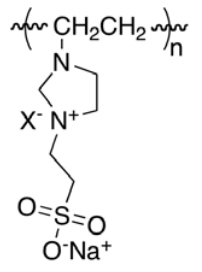
X - = OH - , SH - , SCN - , Cl - , F - , BF 4- , CH